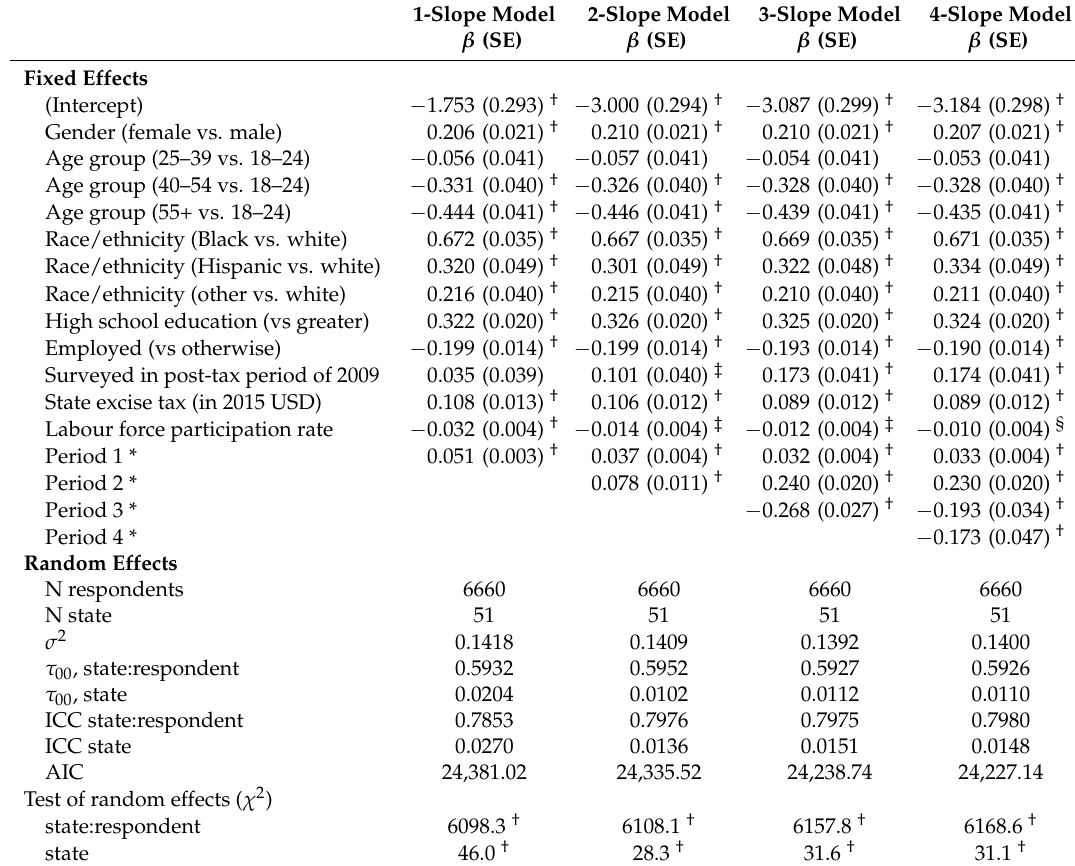
Table 3. Comparison of temporal trends in log(relative income price) across the United States, 2003–2015 ( n = 12,322